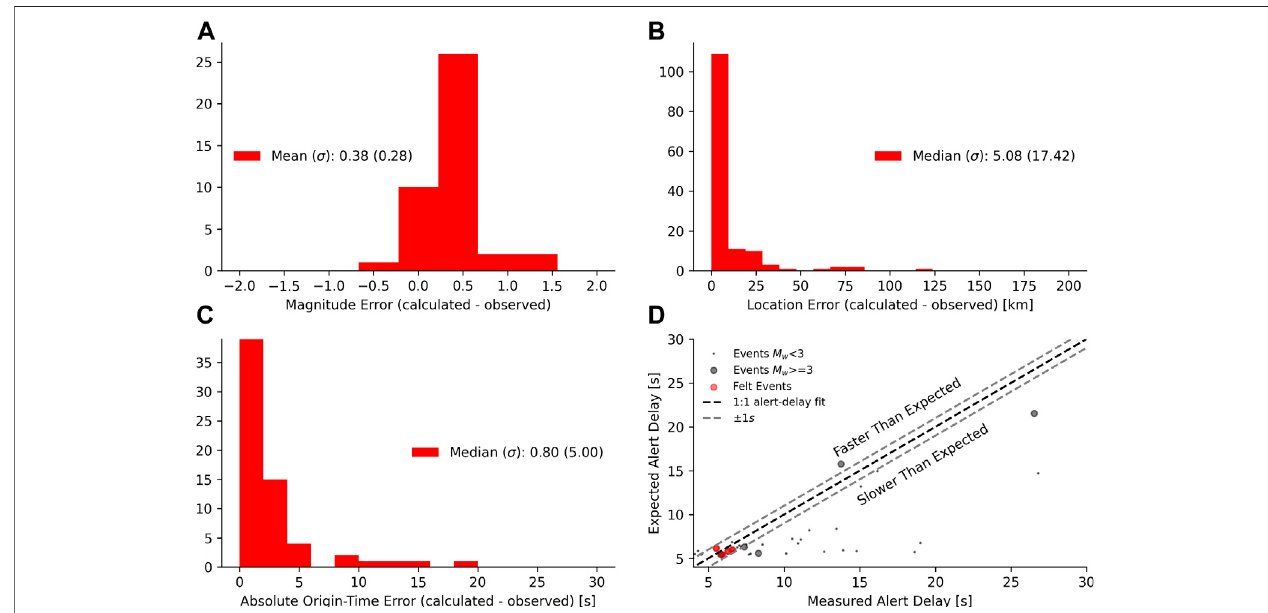
FIGURE 2 | EPIC real-time performance evaluation. (A) magnitude errors; (B) location errors; (C) origin time errors; (D) measured alert delays vs. expected alert delays( NofandKurzon,2021;Seetheir Figure3 forexpectedalertdelaysspatialdistribution ).DotsdenoteeventswithcatalogmagnitudeofMw < 3,graycirclesdenote events with catalog magnitude Mw > 3, red circles represent felt events, dark dashed line represents a 1:1 fi t between expected and measured alert delay, gray dashed lines represent ± 1 s from the 1:1 fi t line; All errors are referenced to the ISN catalog.